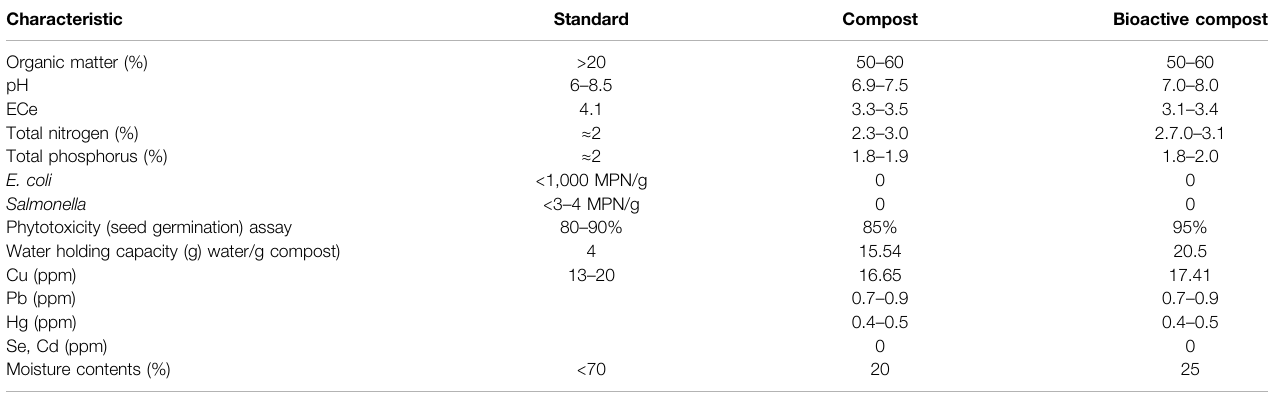
TABLE 1 | Characteristic of the compost and bioactive compost.